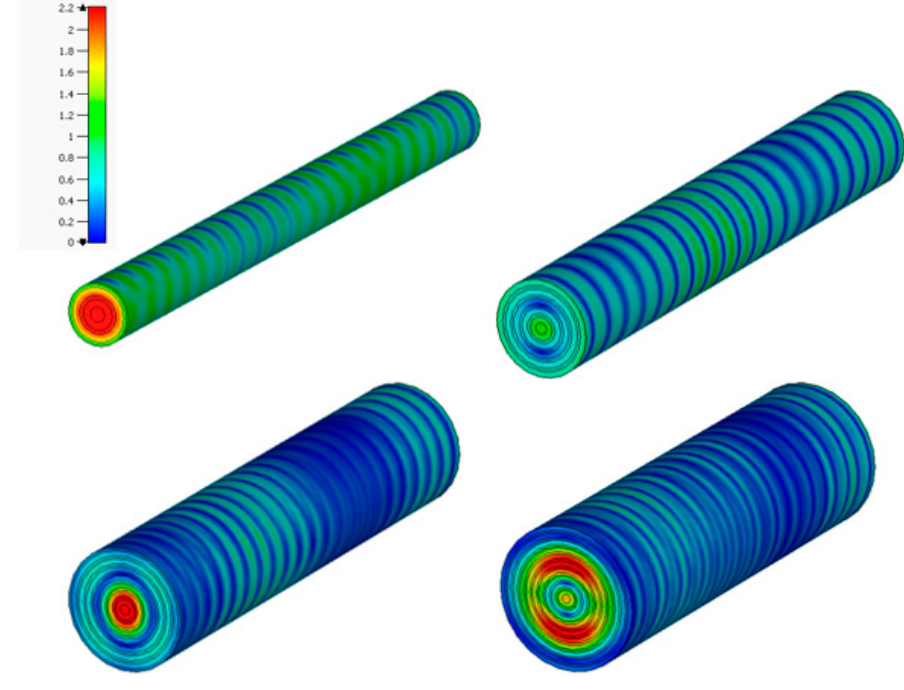
Figure 9. Electric field distribution inside wet poplar wood with different values of the number of growth rings with 50% permittivity variation at 3 GHz. The dielectricic constant values considered are the same as the Figure 7.